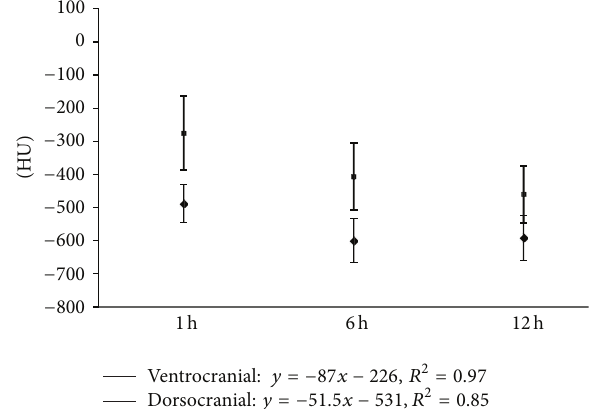
Figure 6: Development of the caudodorsal and caudoventral X- ray absorption values in HE of the subjects in group A ( 𝑛 = 15 ) at the predefined measurement times of the first day of life ( ⬦ = dorsocranial , ◻ = ventrocranial).